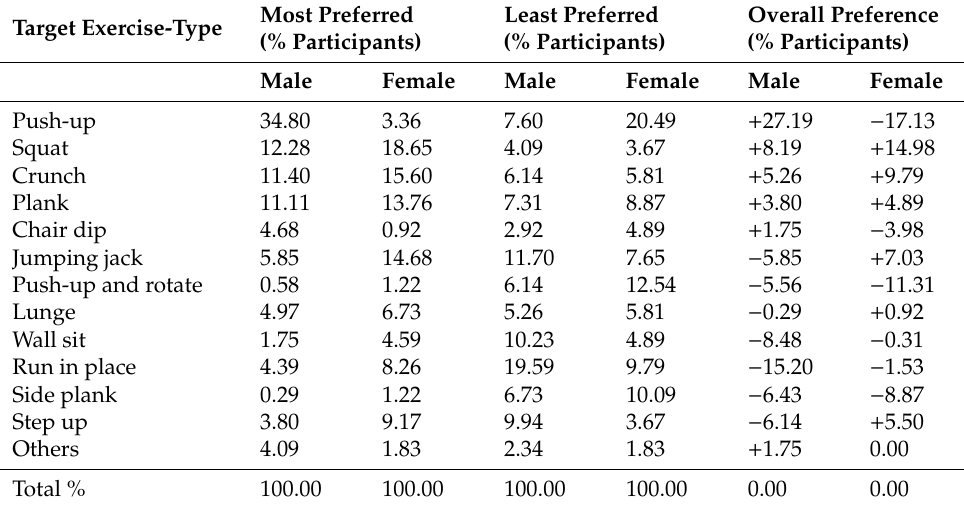
Table 3. Overall preference for each of the twelve exercise types. Positive overall preference indicated that the percentage of participants that chose the exercise as most preferred was higher than the percentage of participants that chose the exercise as least preferred. The reverse was the case for the negative overall preference.